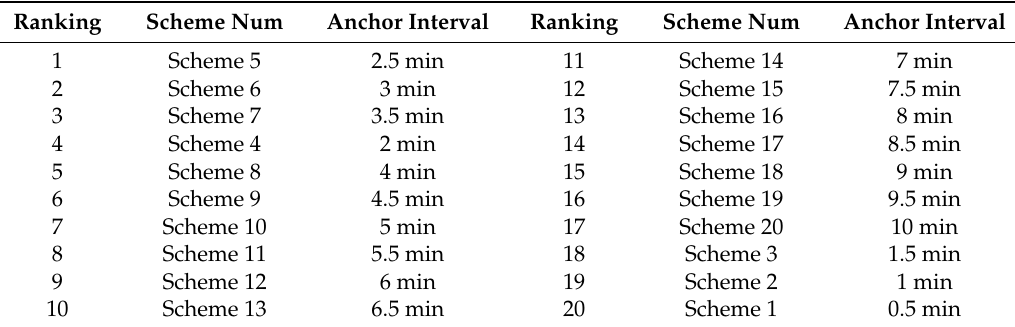
Table 2. Ranking results for 20 candidate